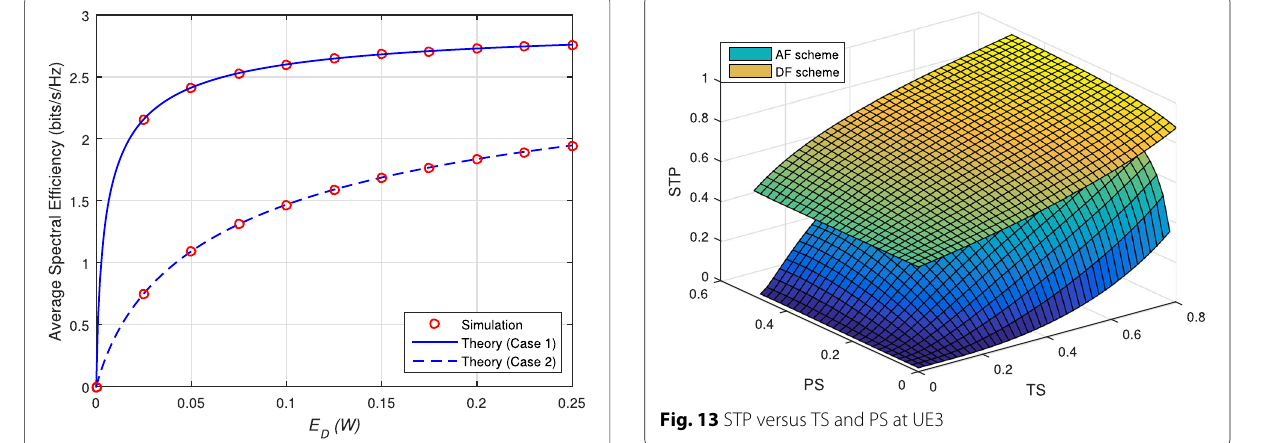
Fig. 11 Average SE versus E D (W) in P2P communication under the impact of HWIs